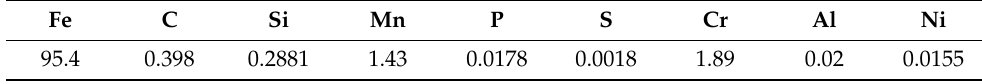
Table 1. Chemical composition (mass%) of 2311 die